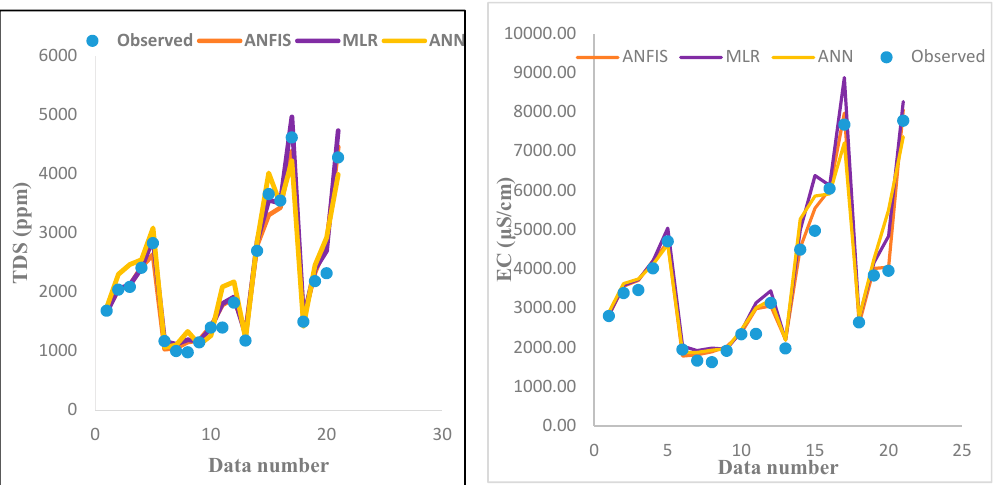
Figure 11. Time series of observed and predicted TDS and EC values for validation dataset.